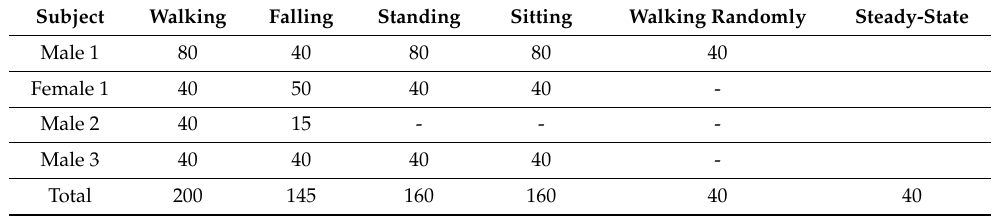
Table 1. Summary of the number of activities performed by the